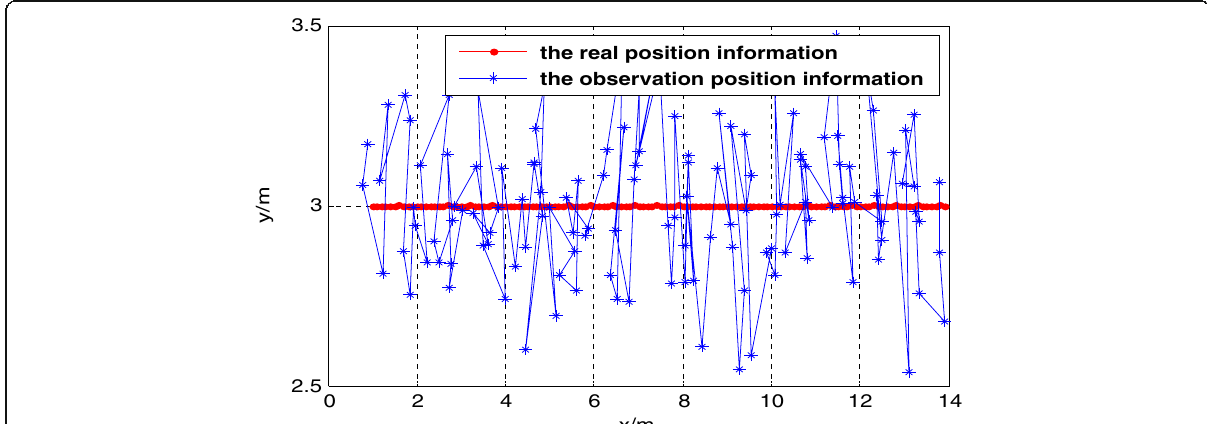
Fig. 4 The uniform motion of the robot is true. The robot moves from the point (0, 3) to the point (14, 3) along the line, and the movement azimuth θ = 0°. Without Kalman filter, the probability of positioning error is 80% within 2m, while after Kalman filter, the positioning error is controlled within 1m